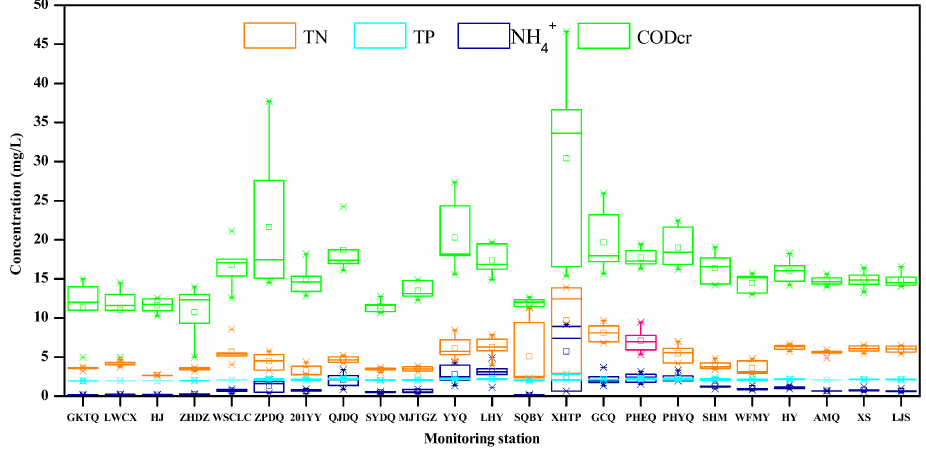
Figure 4. The variation of TN, TP, NH 4+ and CODcr in monitoring station.